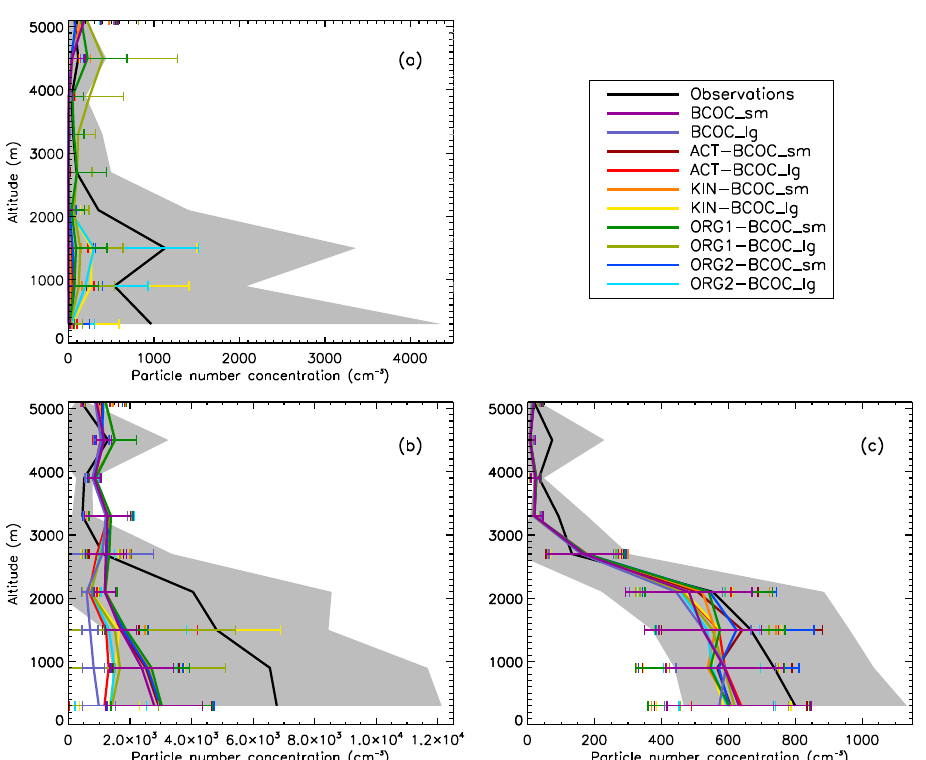
Fig. 8. Vertical profiles of observed (black) and modelled (colour) particle number concentrations in the diameter ranges: (a) 4–10nm, (b) 10–160nm, and (c) 160–1040nm. Observations are from the DLR Falcon 20 aircraft. The average over all measurement flights performed during the LONGREX campaign (May 2008) is shown (sectioned into 600m altitude bins). The error bars and shading represent the standard deviation of the model and observations, respectively. Model experiments listed in the legend are described in Table